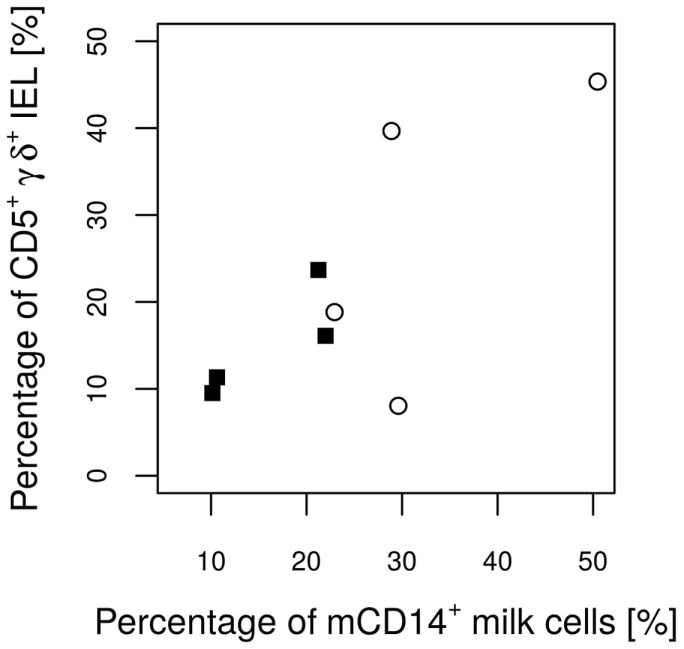
Percentages of CD5+ γδ T cells from all IEL in the piglets’ epithelium on day 26 in relation to the CD14 value of the attendant sow milk measured on day 17 of lactation. The Pearson correlation coefficient (ρ = 0.77) indicates a significant (P = 0.027) linear positive dependence.